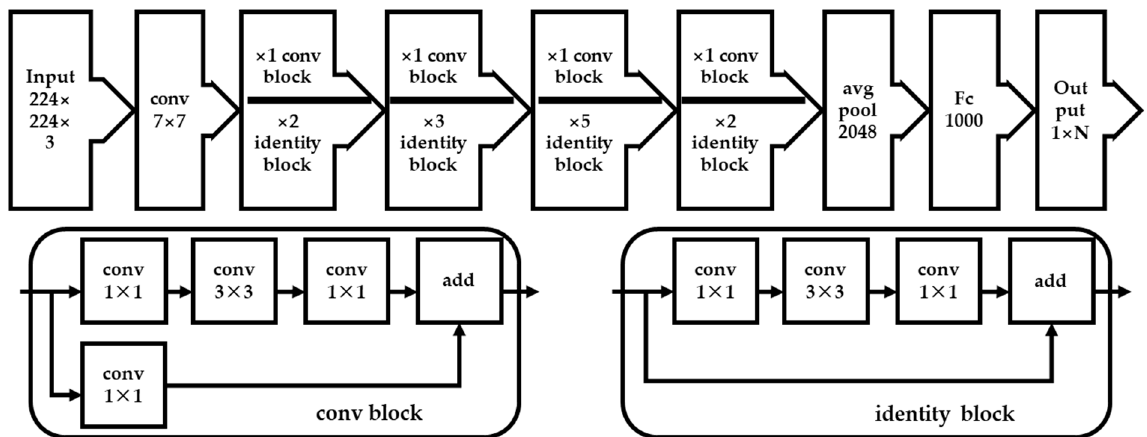
Figure 2. Deep feature extraction based on ResNet50 architecture.